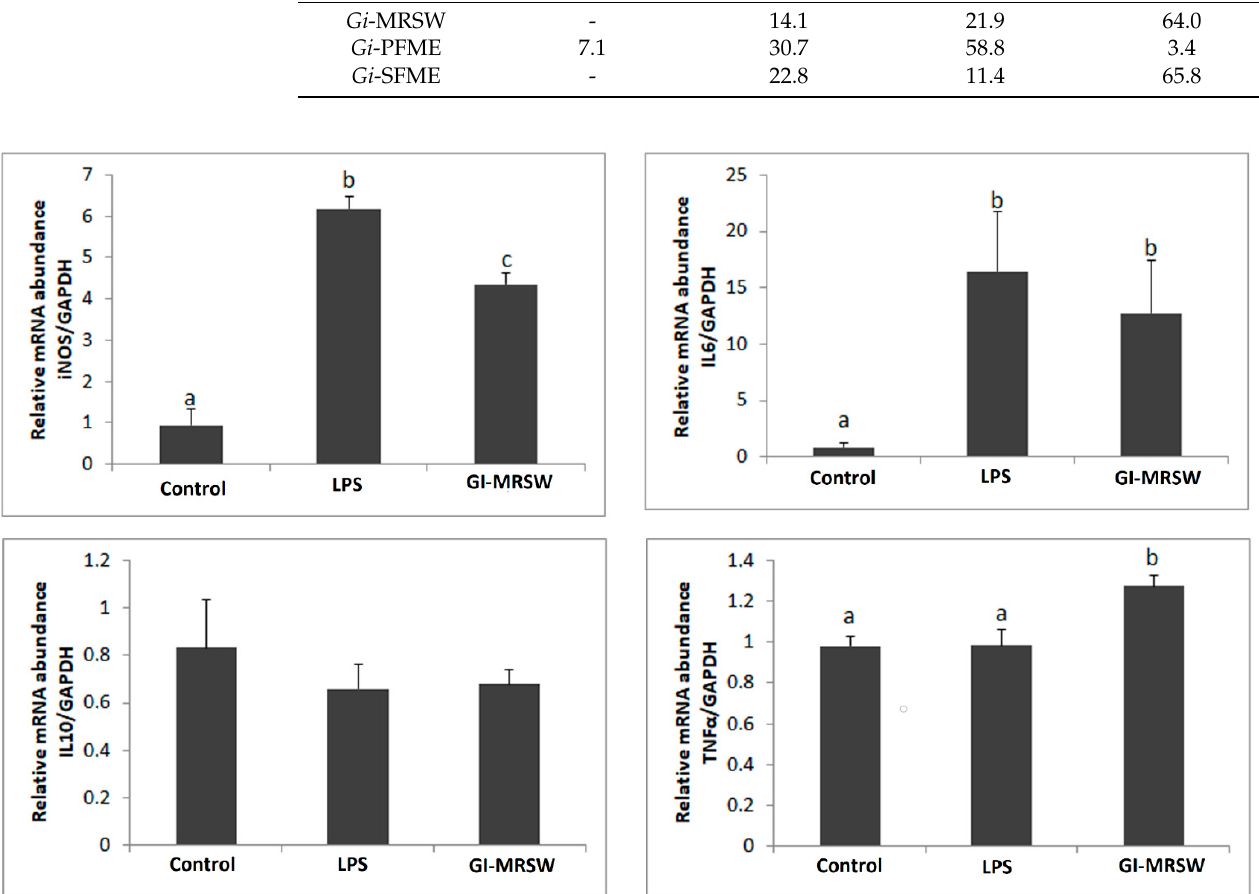
Figure 2. Relative mRNA abundance determined by qPCR after 24 h of the treatment using GAPDH as a housekeeping gene. RAW 264.7 cells were treated with LPS (200 ng/mL) or fraction Gi -MRSW at 40 µg/mL for 24 h. Different letters represent groups with significant differences in gene expressions pattern.